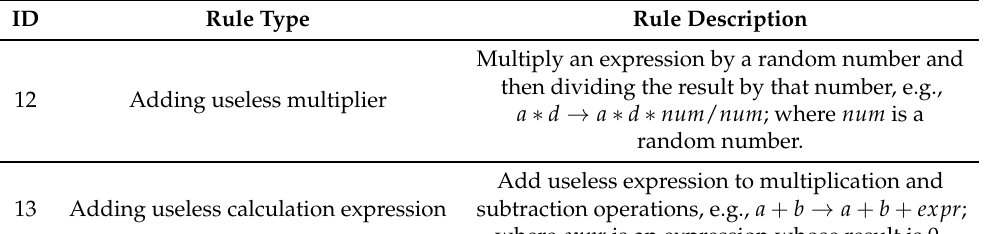
Table 3. Bogus code transformation